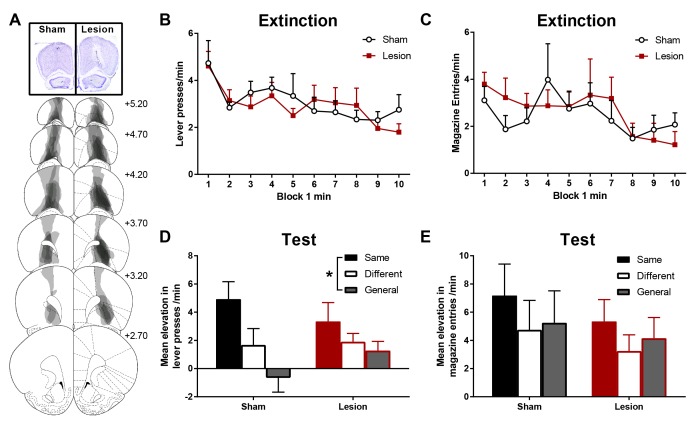
The effects of excitotoxic OFC lesions on specific Pavlovian-to-instrumental transfer (PIT).(A) Representative OFC lesion damage in the lesion group. Semi-transparent grey patches represent lesion damage in a single subject, and darker areas represent overlapping damage across multiple subjects. Coronal sections are identified in mm relative to bregma (Paxinos and Watson, 1997). Rate of lever pressing (B) and magazine entry behaviour (C) during extinction of the instrumental response prior to PIT testing. Instrumental lever pressing (D) and magazine entry behaviour during the specific PIT test. Responding plotted as the mean response rate per minute during each cue minus the preceding baseline no-cue period. Same and different conditions indicate whether the Pavlovian CS predicted the same or different liquid reinforcer to the instrumental response, the general condition indicates responding during the CS that predicted pellets which were never an instrumental reinforcer. Error bars depict + SEM. (*) Symbol denotes statistical significance of simple or main effects following a significant interaction.